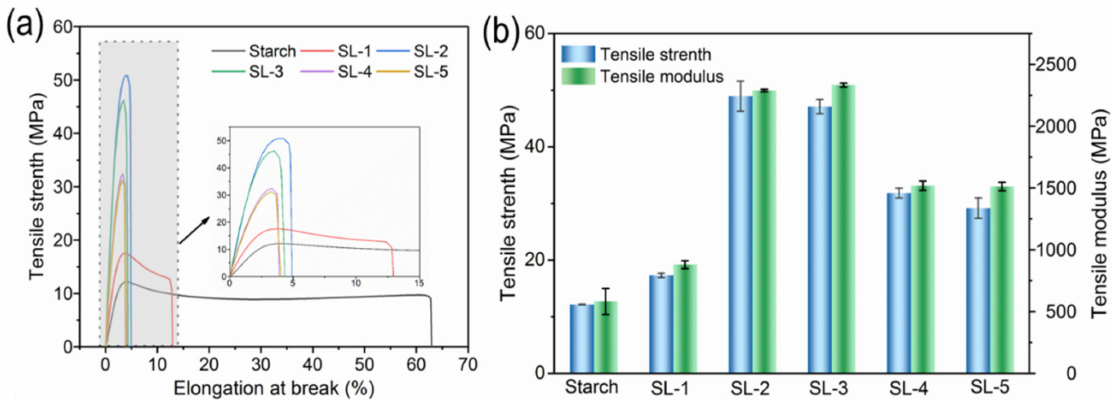
Figure 7. ( a ) Stress–strain curves and ( b ) Tensile strength and modulus of starch film and SL composite films containing 1% to 5%